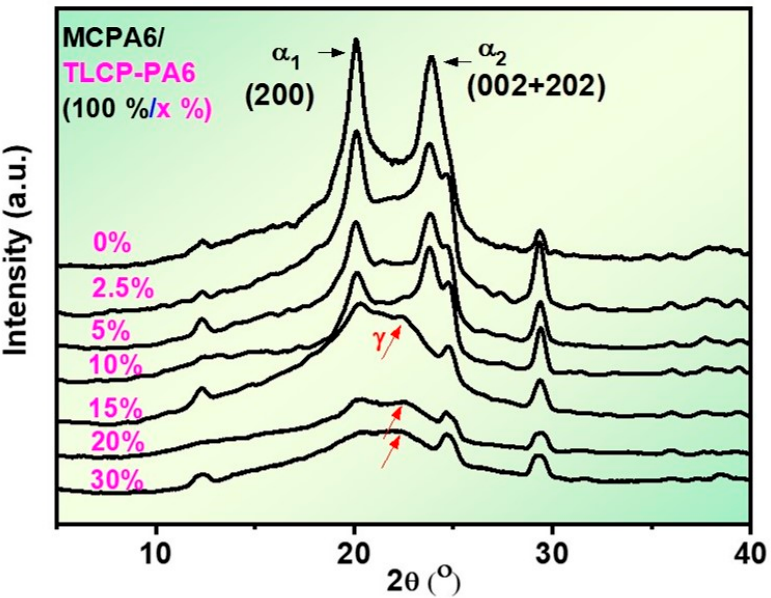
Figure 6. WAXRD results of MCPA6/TLCP-PA6 blended samples (100 wt. %/x wt. %) with the different content of TLCP-PA6 (x wt. % = 0~30 wt.